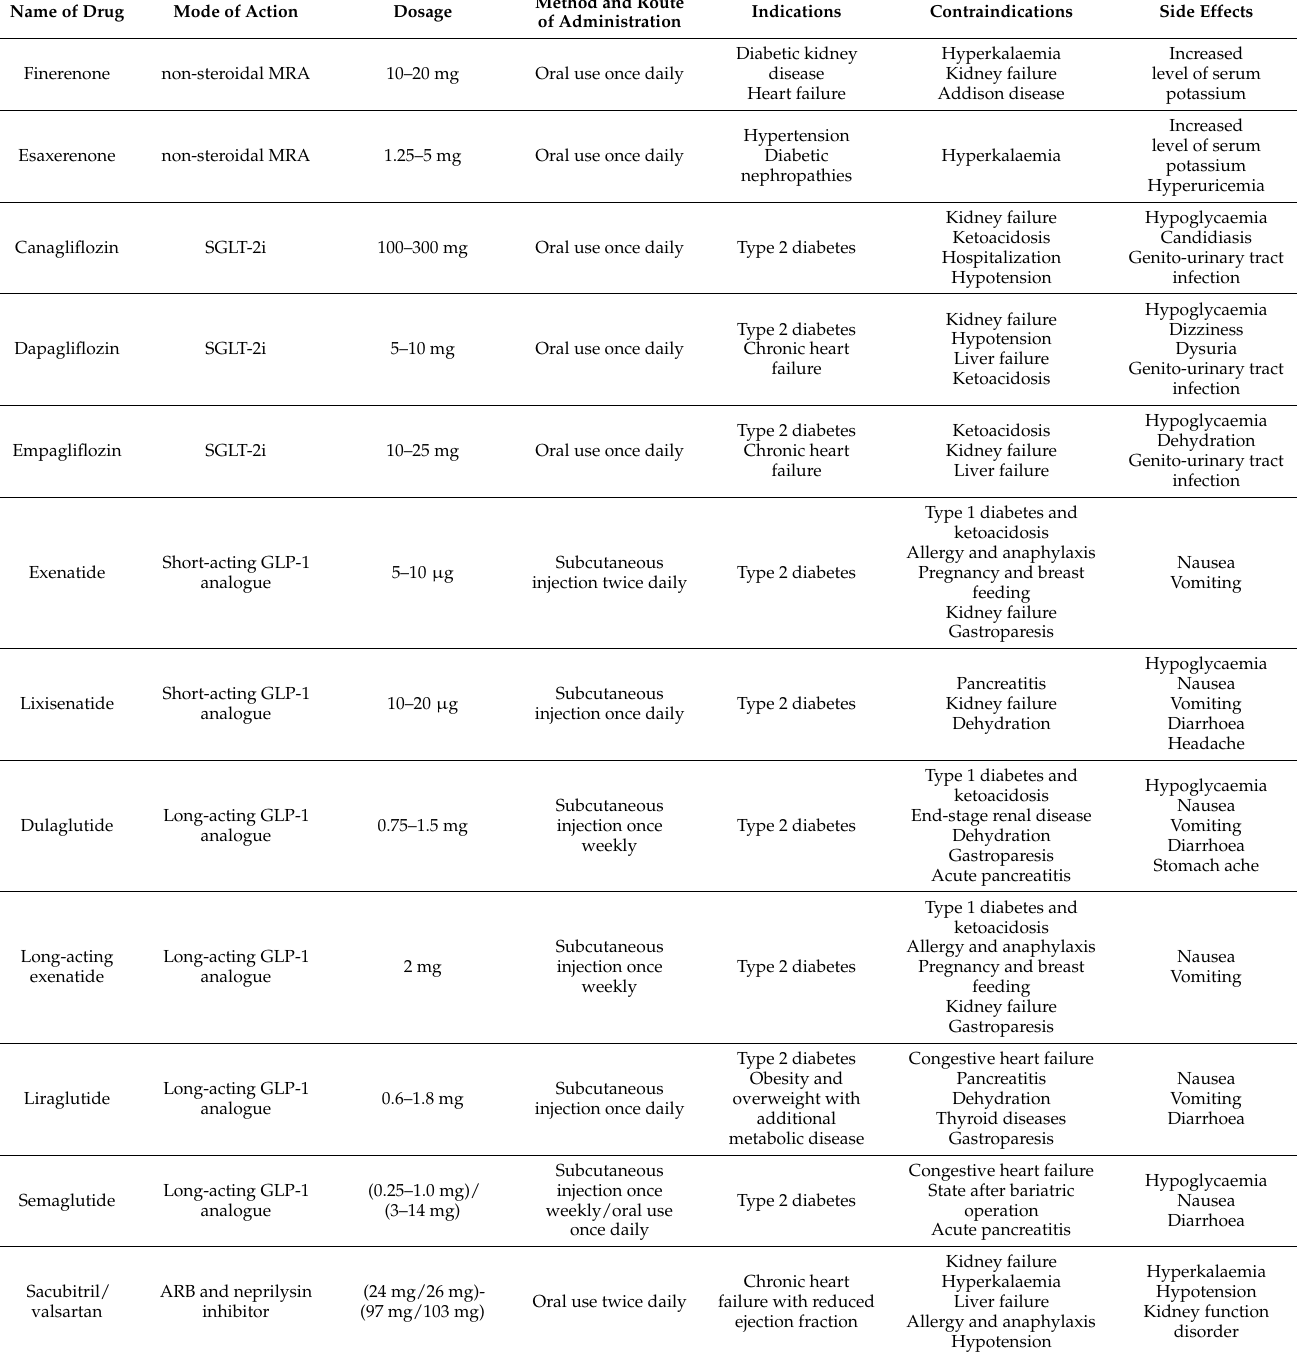
Table 2. Comparison of novel antihypertensive drugs